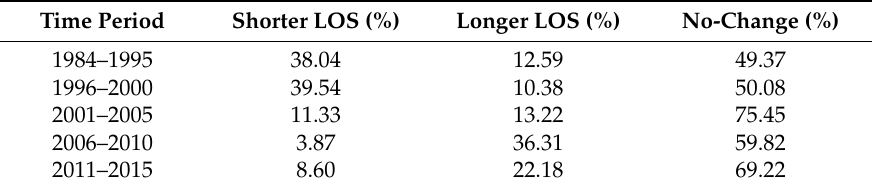
Table 5. Percentages of longer LOS, shorter LOS, and no-change of LOS within the east-west transect for the five time periods.